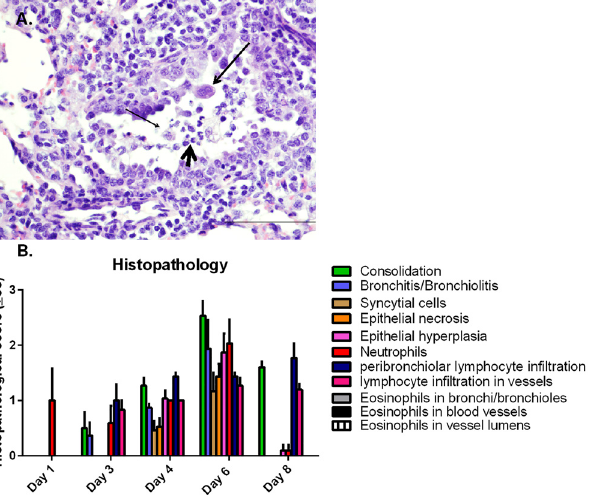
Fig 3. Microscopic lung lesions severity score in M37 hRSV infected neonatal lambs. (A) Histopathologic lesions included bronchiolitis with degenerate/necrotic individual epithelial cells (thin arrow), occasional syncytial cells (long arrow), accumulation of degenerate neutrophils (short arrow), and occasional macrophages. H&E Bar = 50 μ m. (B) A histologic score was given by determining percent consolidation followed by conversion to an integer-based consolidation scale used by our laboratory previously [1]: 0% consolidation = 0; 1%-9% consolidation = 1; 10%-39% consolidation = 2; 40%-69% consolidation = 3; 70%- 100% consolidation = 4. Group averages were calculated for alveolar and bronchiolar consolidation scores. In addition to the consolidation score, bronchitis, bronchiolitis, neutrophil infiltration, peribronchiolar and perivascular infiltration of lymphocytes, syncytial cell formation, and epithelial alterations were also scored. Results are indicated as mean ± standard error for each scored parameter.